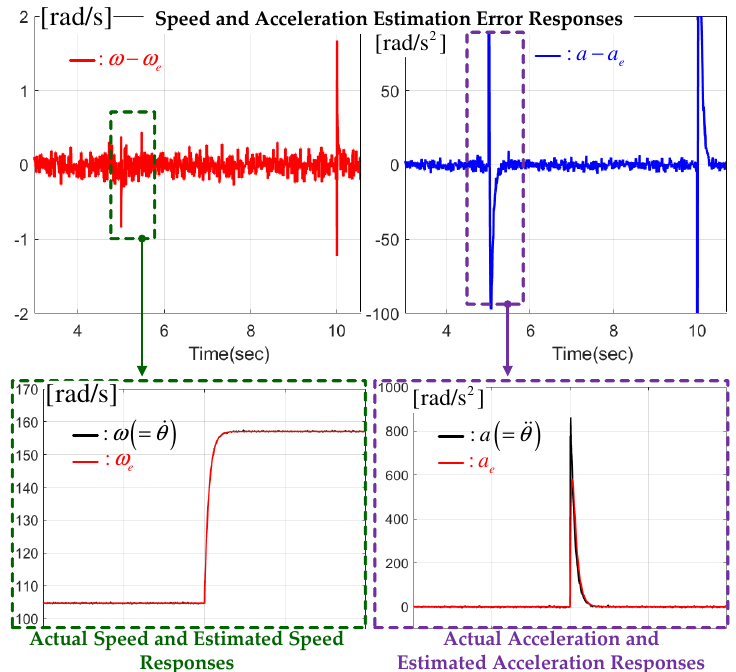
Figure 5. Comparison of observer responses in stair speed reference tracking